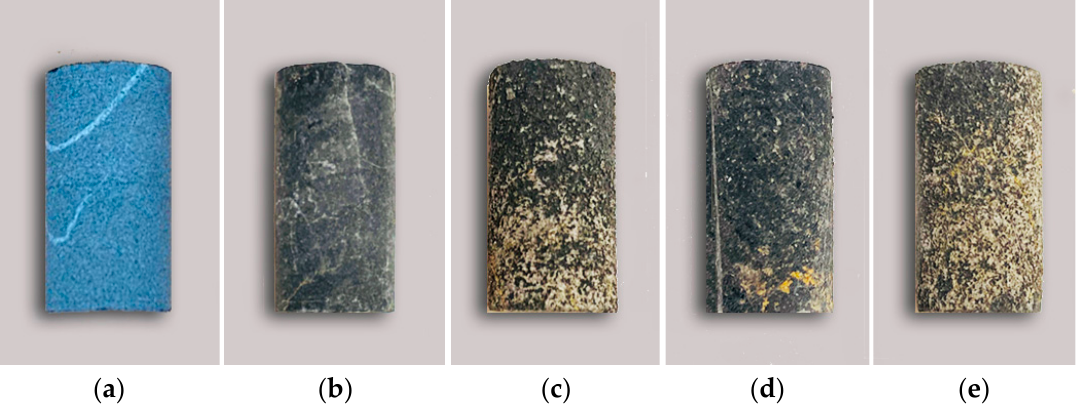
Figure 7. Comparison diagram of rock samples before and after dissolution: ( a ) Original sample; ( b ) Test condition 1; ( c ) Test condition 2; ( d ) Test condition 3; ( e ) Test condition 4. Table 4. The dissolution rate of carbonate rocks under four groups of test